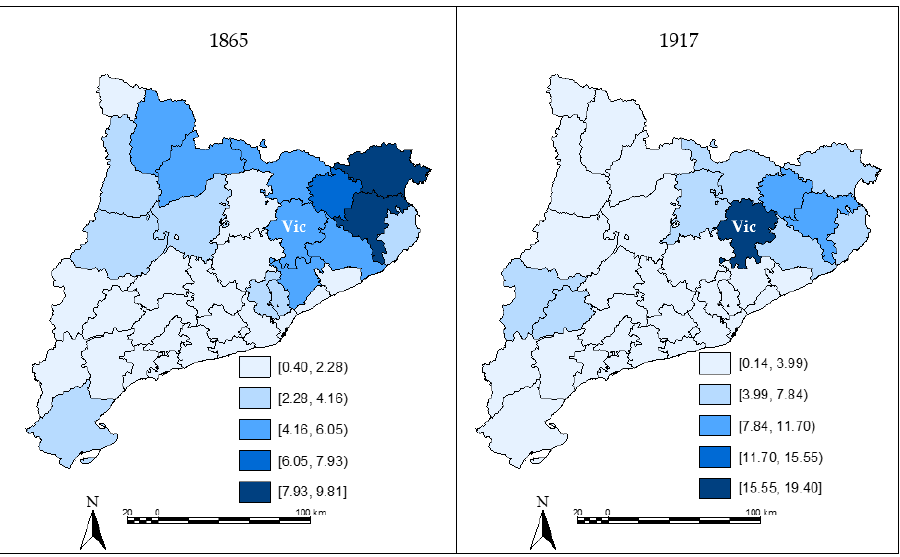
Figure 6. Pig distribution in Catalonia by districts, 1865 and 1917 (in percentages). Notes and Source: Authors’ own elaboration based on [46,55,102]. Adjustments in changing boundaries have been taken into consideration when necessary.